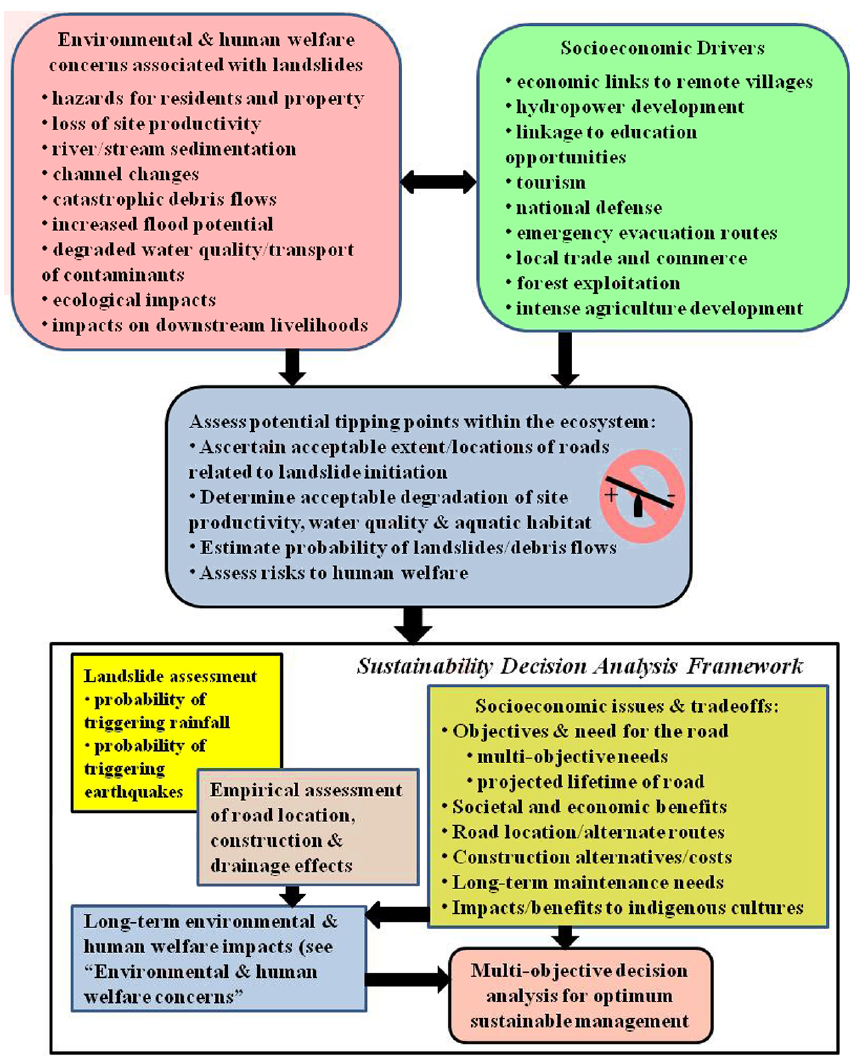
Figure 8. Decision framework for sustainability assessment of mountainous terrain in northwestern Yunnan, China, where extensive road construction is being proposed (modified extensively from Sidle et al.,